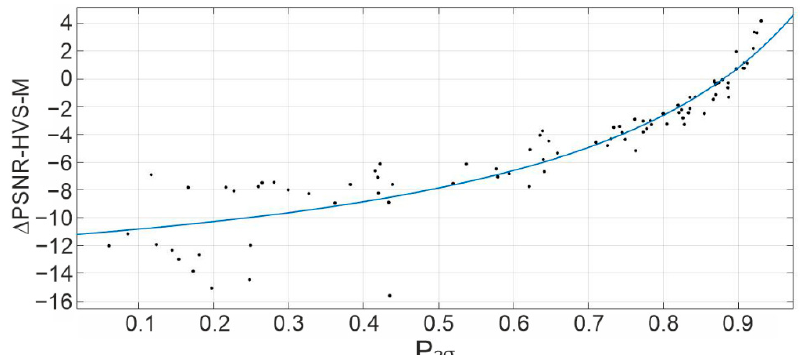
Figure 8. The scatter-plot ∆𝑃𝑆𝑁𝑅 vs. 𝑃 2𝜎 and the fitted curve.